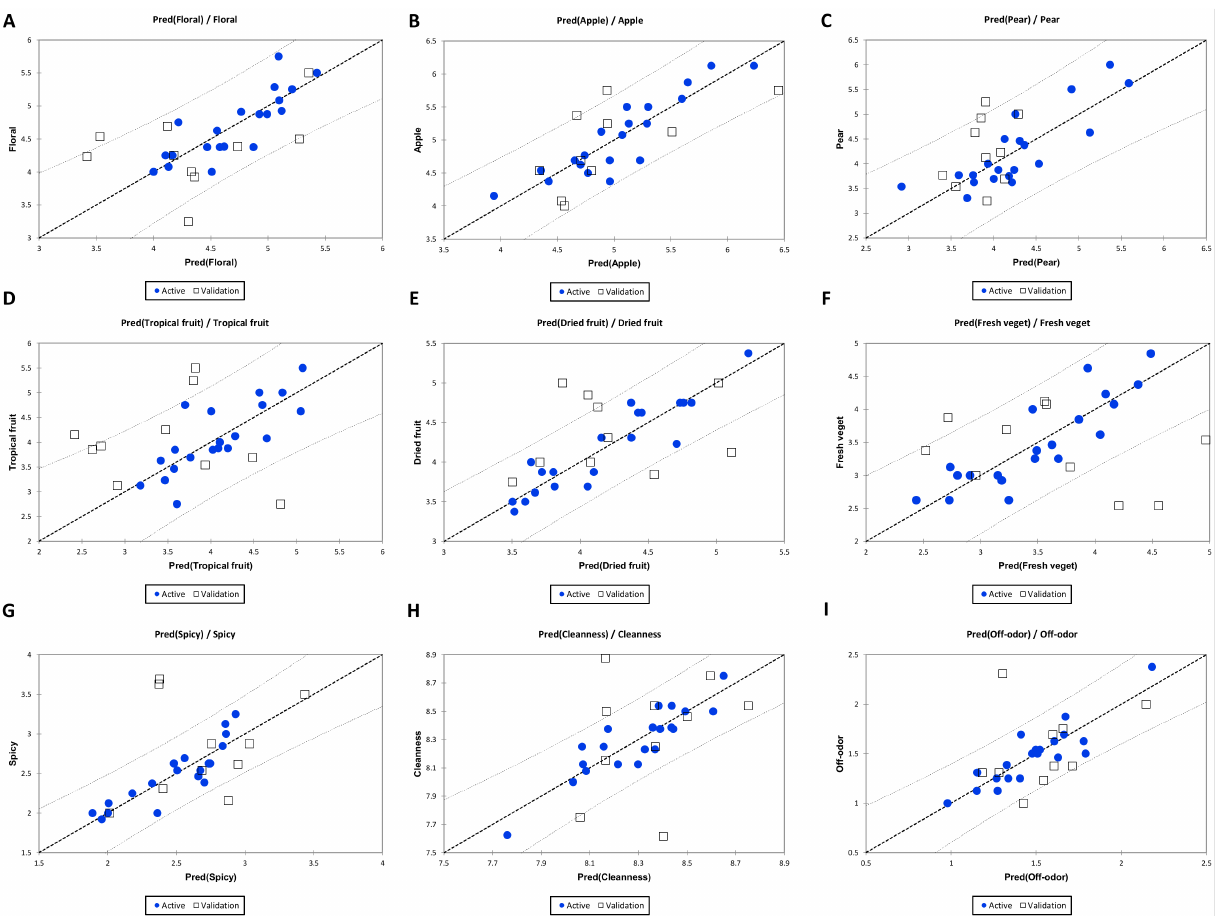
Figure 2. Predicted/observed regression plots calculated on the PCR on volatile compounds (the confidence interval is set at 95%) for olfactory descriptors: ( A ) Floral; ( B ) Apple; ( C ) Pear; ( D ) Tropical fruit; ( E ) Dried fruit; ( F ) Fresh veget.; ( G ) Spicy; ( H ) Cleanness; ( I )